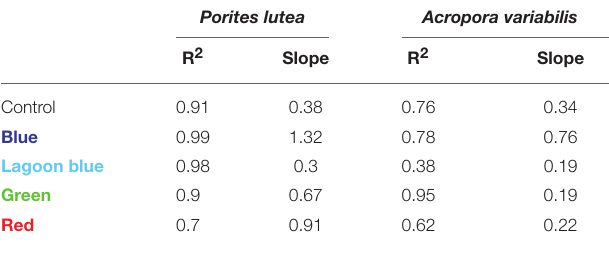
TABLE 2 | Slopes and R 2 derived from a linear regression relationship between calcification and photosynthesis of the corals P. lutea and A. variabilis .